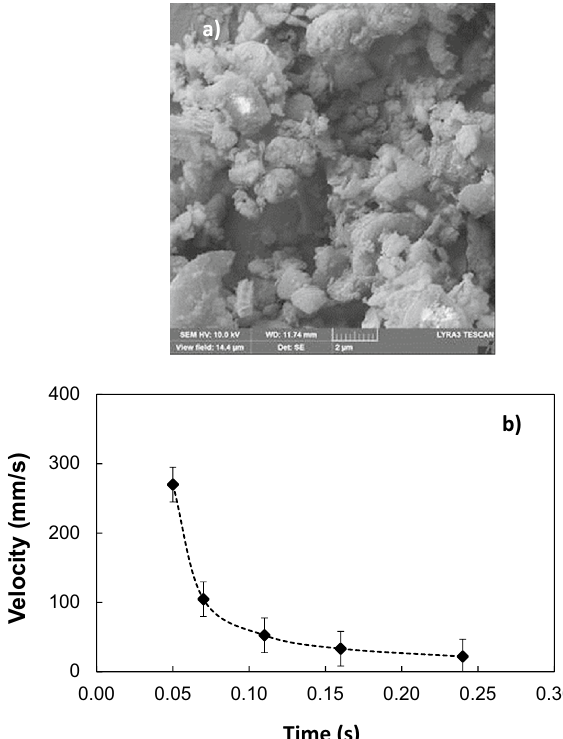
Figure 9. SEM micrographs of dust and infusion velocity of water over dust particle: ( a ) dust particles with various sizes and shapes, and ( b ) infusion velocity of water over dust particle.